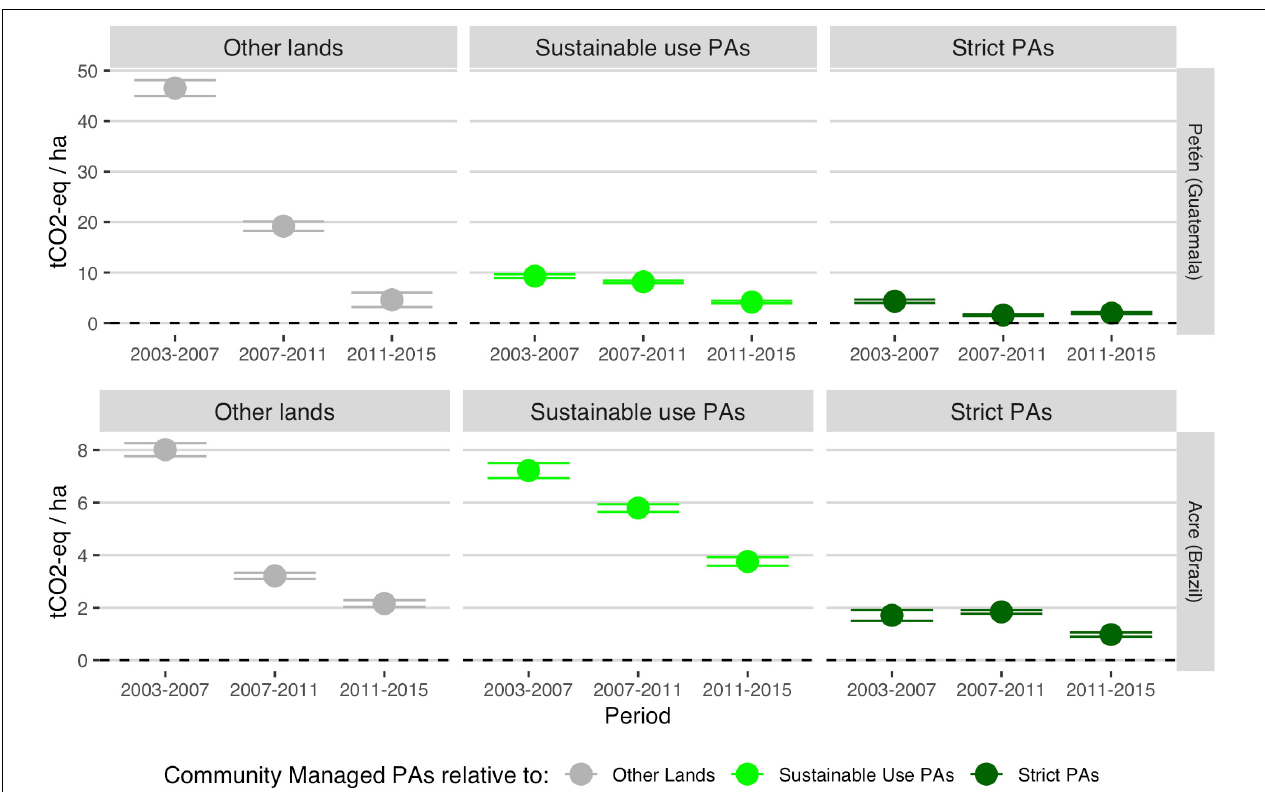
FIGURE 5 | The temporal effects of Community Managed PAs on avoided carbon emissions in Petén (Guatemala) and Acre (Brazil). Positive temporal effects ( p < 0.05) indicate net avoided carbon emissions relative to Other Lands (gray), Sustainable Use PAs (light green), and Strict PAs (dark green). Error bars indicate 95% confidence intervals for temporal